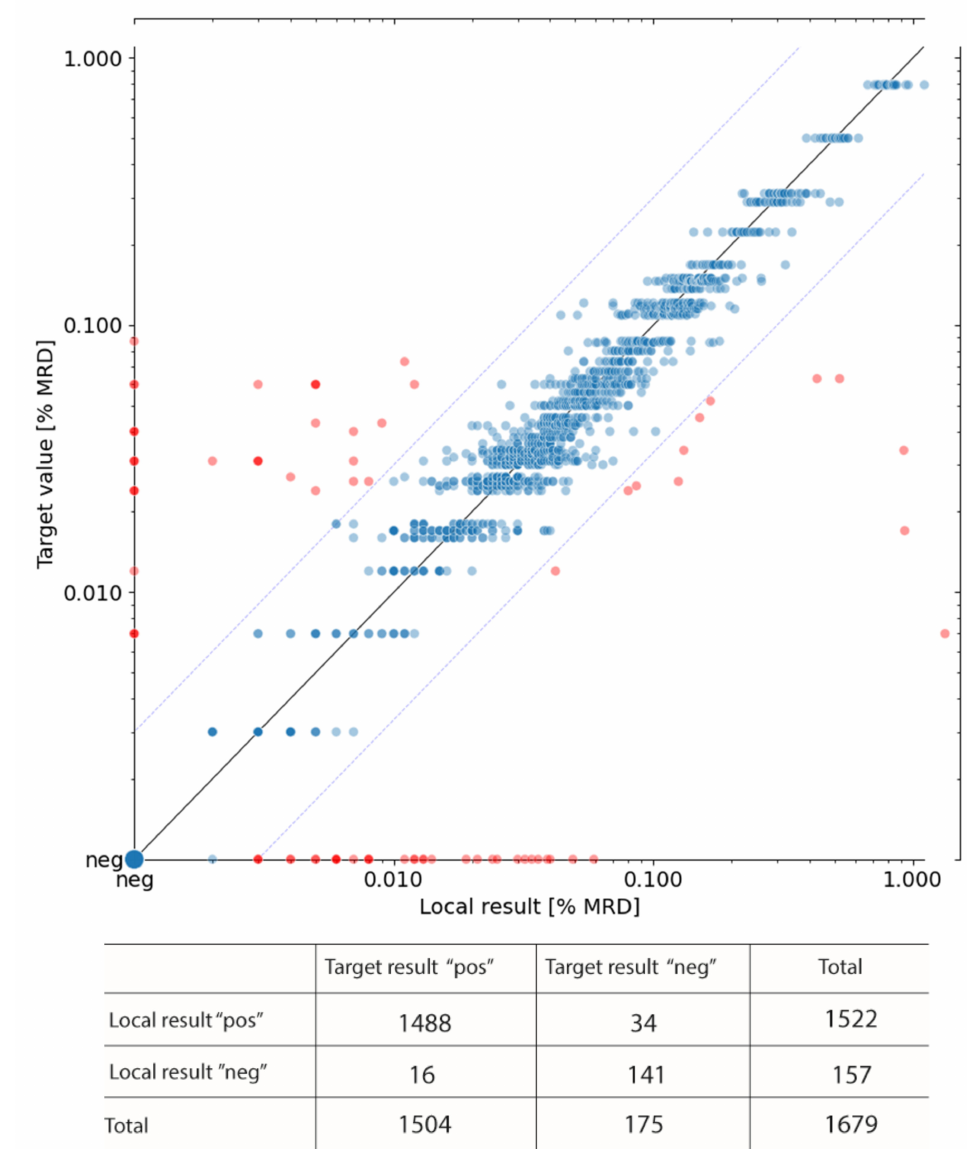
Figure 2. Correlation of the local MRD estimates of UK NEQAS samples analyzed by I-BFM-Flow laboratories. The target value represents the median of all submitted results. Red dots indicate outliers (i.e., MRD results outside the concordance margin, n = 78). Blue dots indicate concordant results ( n = 1601). Positivity was defined as ≥ 10 MRD events among 3 × 10 5 nucleated events, i.e., >0.003% (pos, positive; neg,